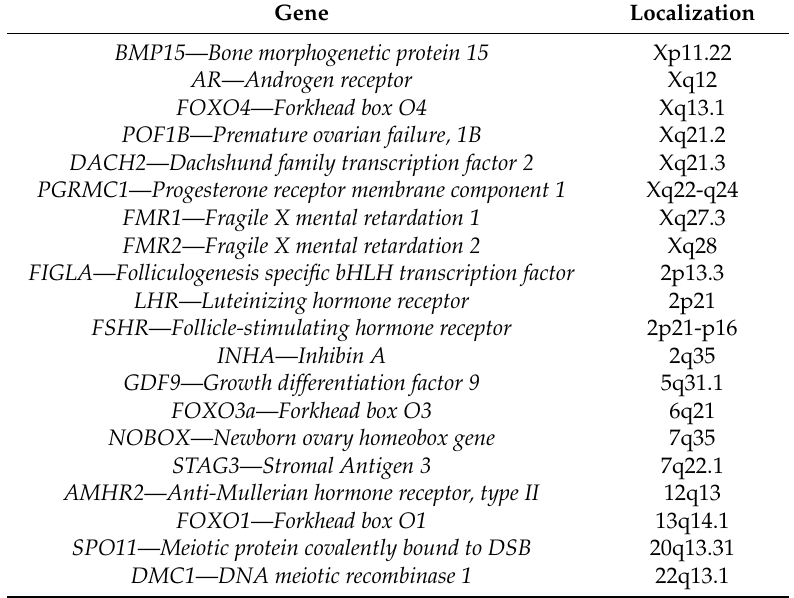
Table 1. Genes that have been associated with primary ovarian insufficiency (POI). Adopted and modified from Qin et al. [15]. Gene Localization